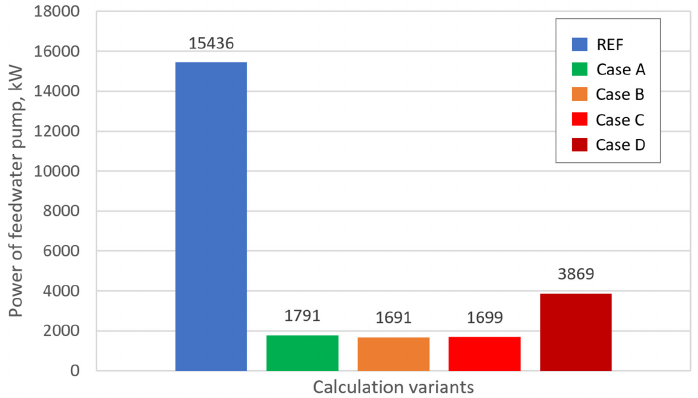
Figure 16. The power of the feed-water pump for different parameters of steam feeding the turbine.